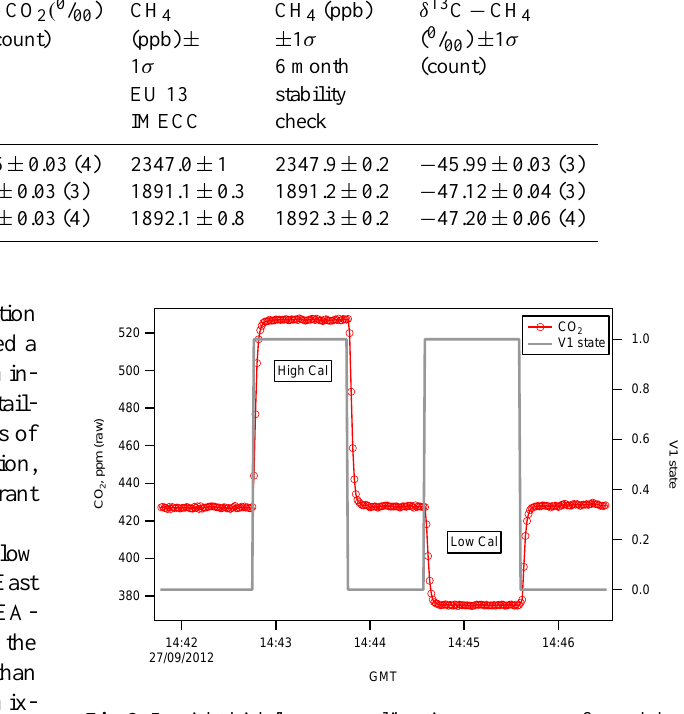
Fig. 3. In-flight high/low span calibration sequence performed dur- ing mission B742. The data shown are 1Hz raw CO 2 ppm, acquired with the Los Gatos Research FGGA